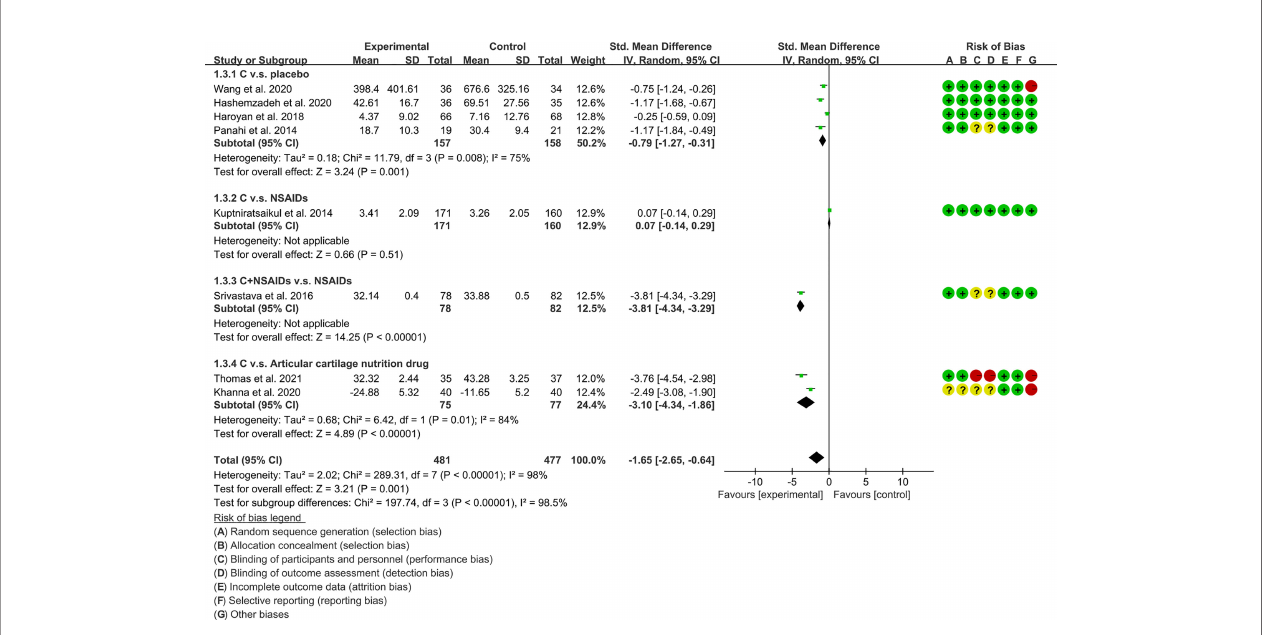
FIGURE 9 | WOMAC-physical